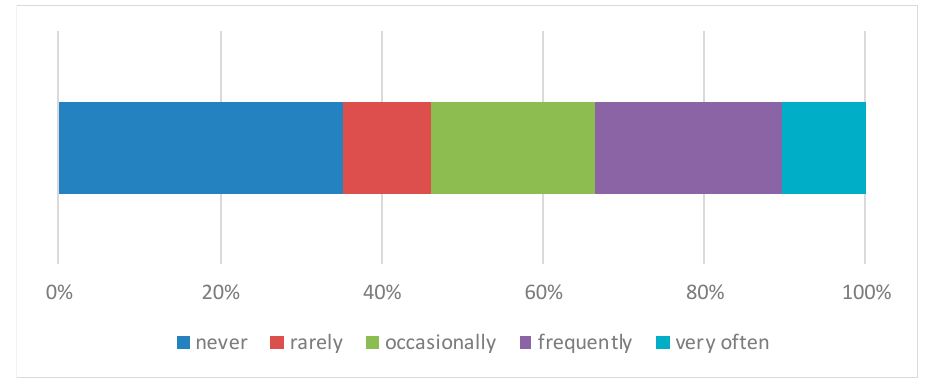
Figure 4. Reception of support classes for the subject.